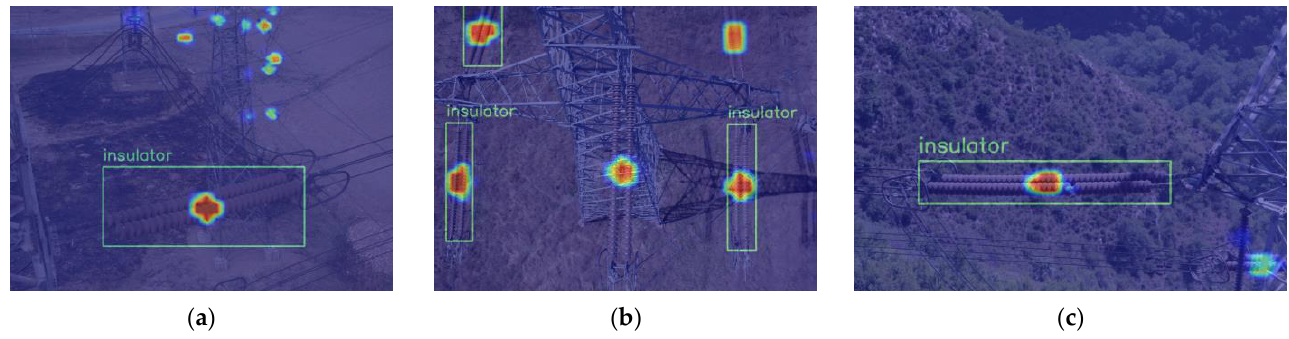
Figure 10. Heat map of the detection of the original YOLOX-S model: ( a ) only one insulator has been detected; ( b ) three insulators have been detected; ( c ) only one insulator has been detected, and the defect has not been detected.